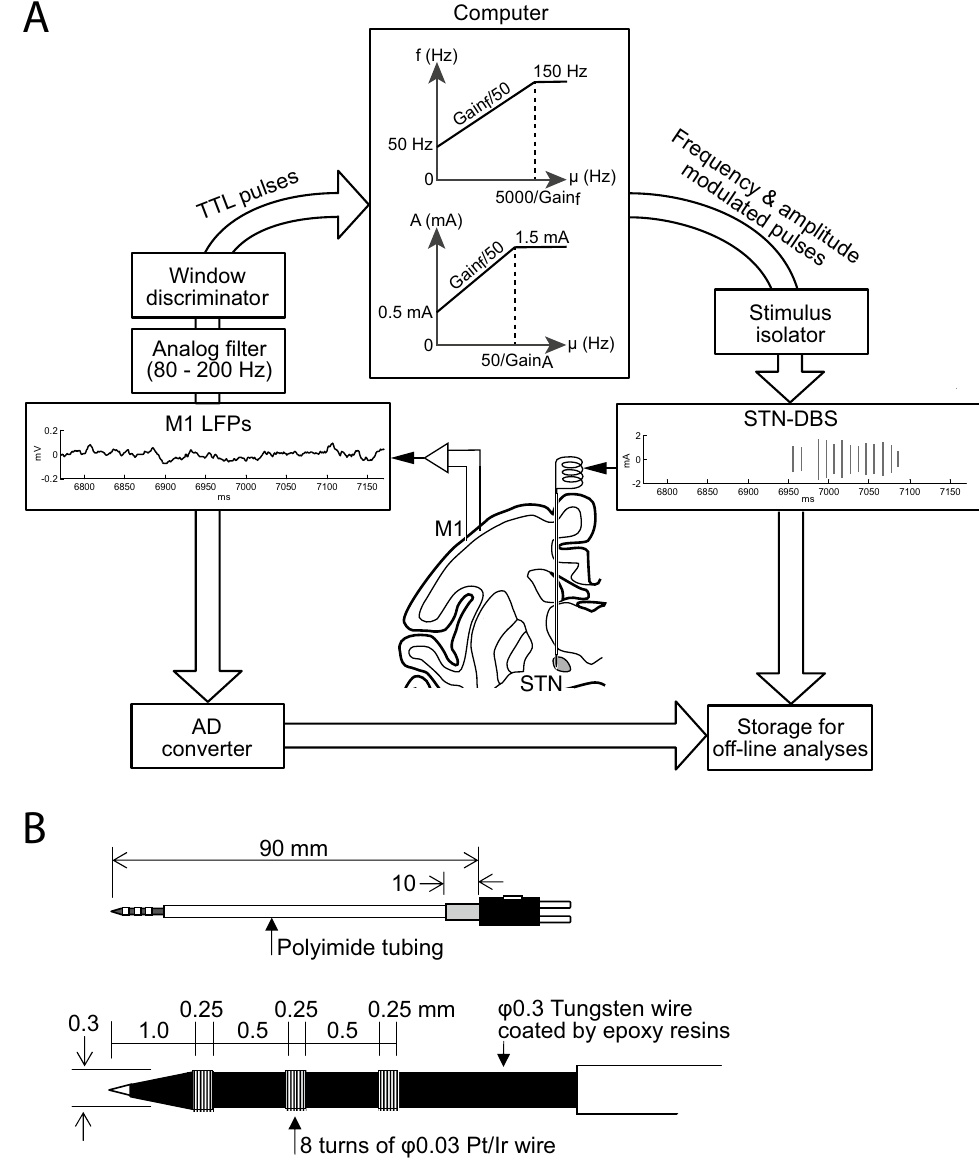
Figure 3. Experimental setup for aDBS driven by M1-local field potentials (LFPs). ( A ) Procedure of aDBS. LFPs were recorded in the M1, amplified, filtered (γ2 band, 80–200 Hz), and converted to transistor-transistor logic (TTL) pulses using a window discriminator that detected LFPs with amplitude > 75th percentile and duration > 0.5 ms. The frequency of the TTL pulse was used to control the amplitude and frequency of the electrical stimulation delivered to the DBS electrode in the STN via an analog stimulus isolator. ( B ) DBS electrode in the STN. Top, entire electrode. Bottom, electrode tip. Pt/Ir, alloy of platinum and